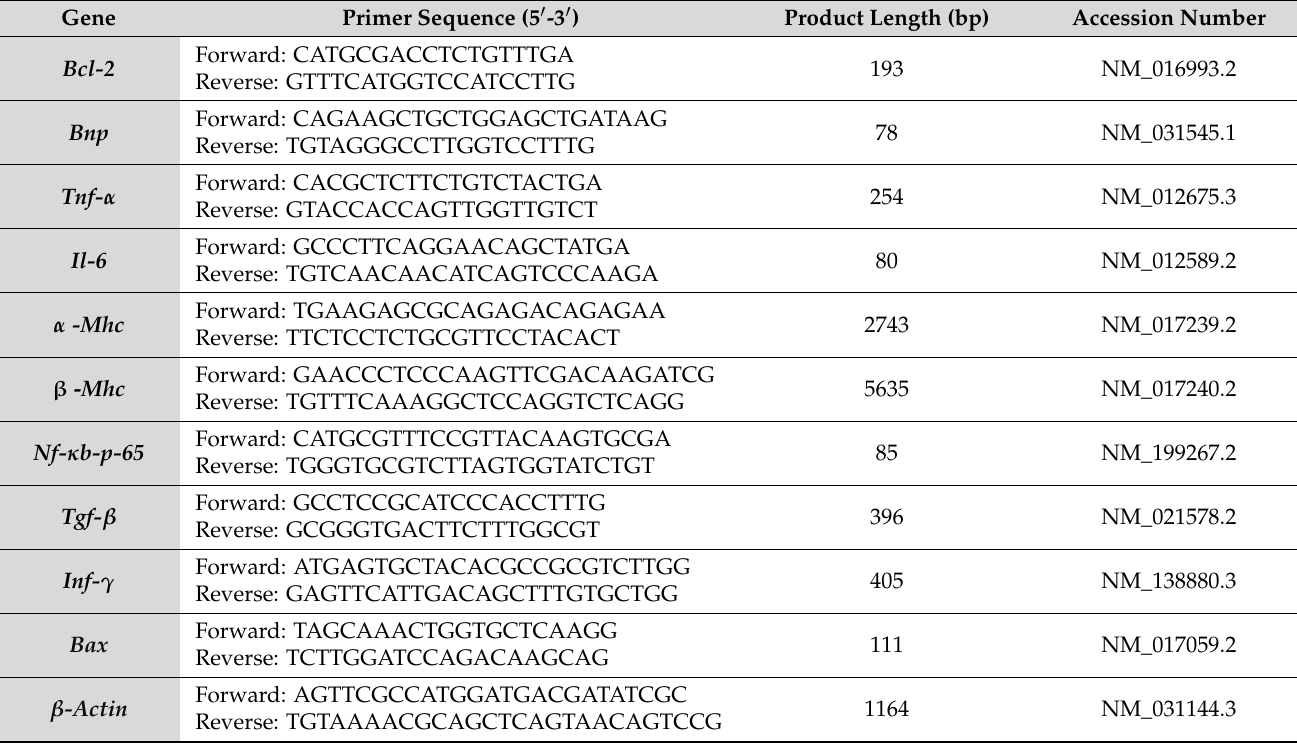
Table 1. List of forward and reverse primers for different genes used in the qRT PCR